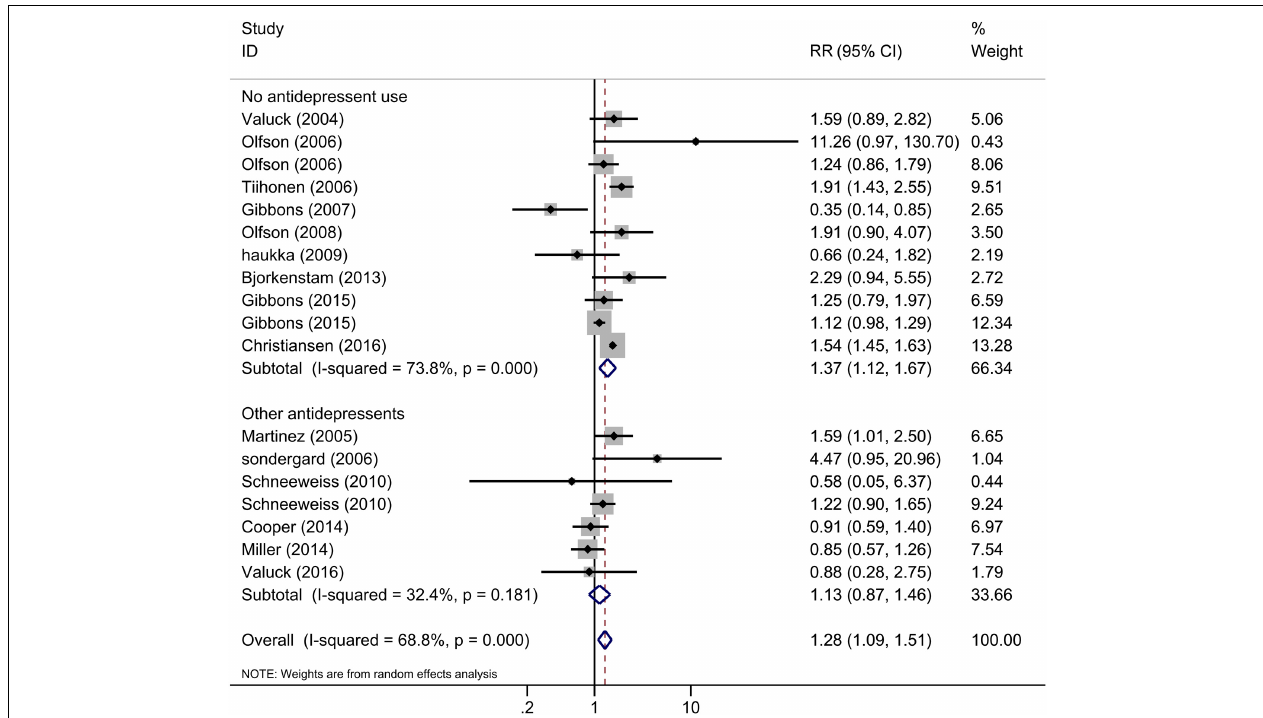
FIGURE 4 | Subgroup analysis of SSRI exposure and risk of suicidal behavior according to the